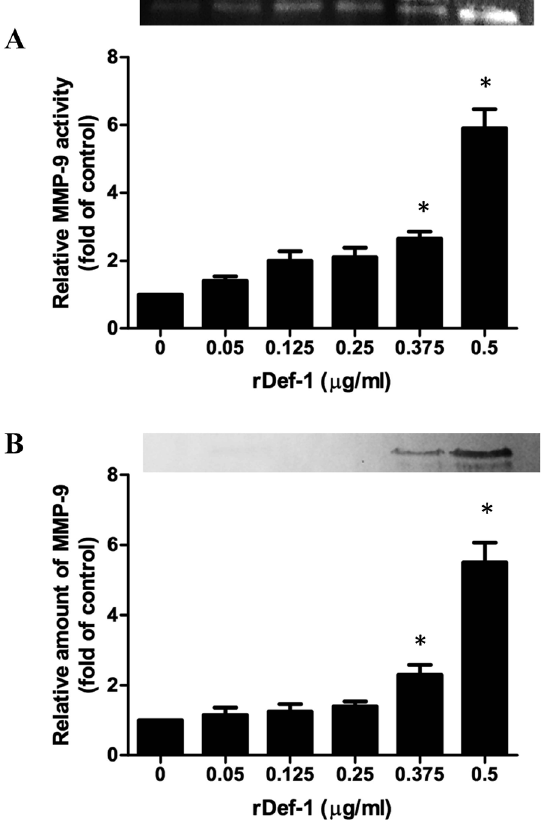
Figure 4. Induction of matrix metalloproteinase 9 (MMP-9) in HaCaT cells using recombinant defensin-1 (rDef-1). Relative amount of MMP-9 and its activity is presented following incubation of HaCaT cells for 72 h with rDef-1 at concentrations ranging from 0.05 to 0.5 µ g/ml. ( A ) Conditioned equal volumes of the culture media were collected and subjected to gelatine zymography. Densitometric quantification of MMP-9 activity in culture media is presented. ( B ) Conditioned equal volumes of the concentrated culture media were subjected to 10% SDS-PAGE gels. MMP-9 (92 kDa) was detected by Western blotting and quantified densitometrically. The gels were run under the same experimental conditions. Shown are cropped gels/blots. (The gels/blots with indicated cropping lines are shown in Supplementary Fig. S4). Data are expressed as means and SEMs of three independent measurements. Asterisks indicate a significant difference from the untreated group, * P <